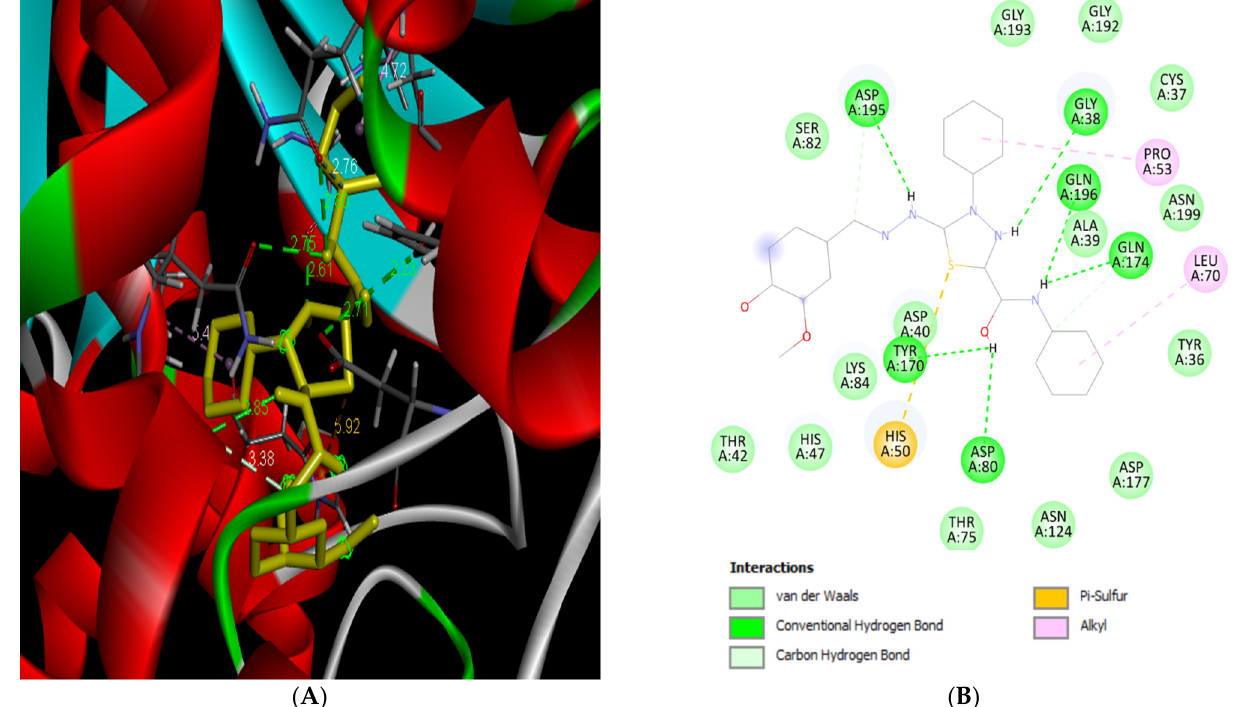
Figure 2 . 2D ( B ) and 3D ( A ) representation of compound 3 docking with TyrRS. Figure 2. 2D ( B ) and 3D ( A ) representation of compound 3 docking with TyrRS. Molecules 2021 , 26 , x FOR PEER REVIEW